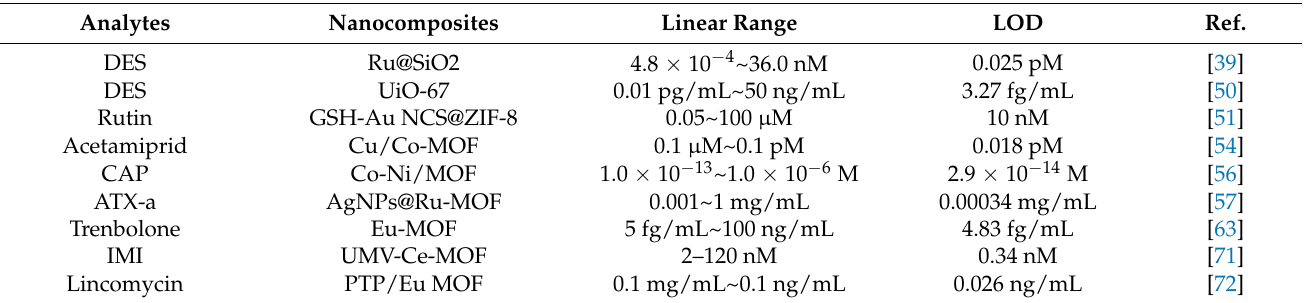
Table 3. Summary of the construction of ECL biosensors based on porous nanocomposites for small molecule